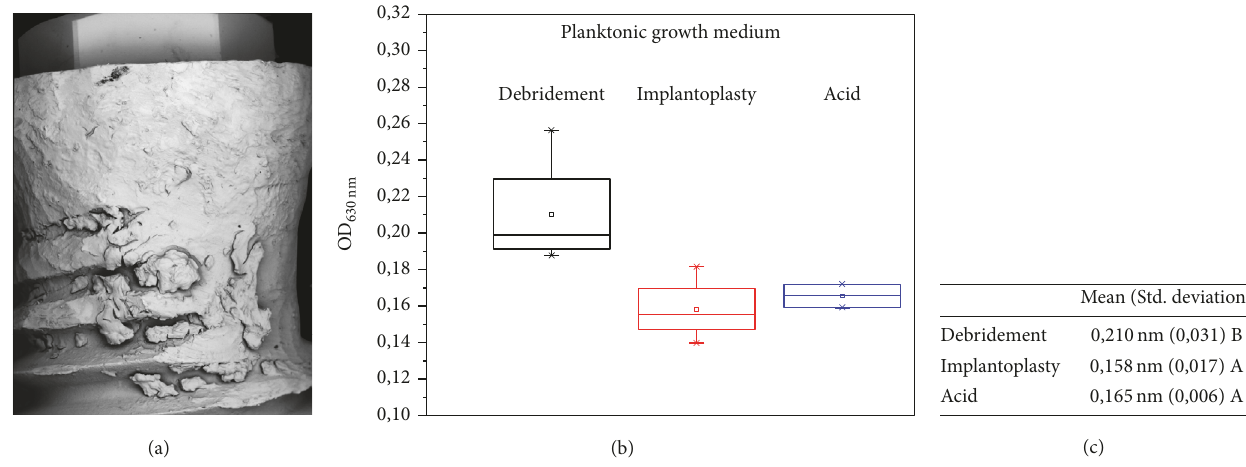
Figure 4: Biofilm formation on implantoplasty treatment surface (a). S. mutans planktonic growth in implants for 48 h in TSB (37 ∘ C), measured by spectrophotometer with an optical density of 630 nm (b) and table exhibiting mean values, according to the specific treatment